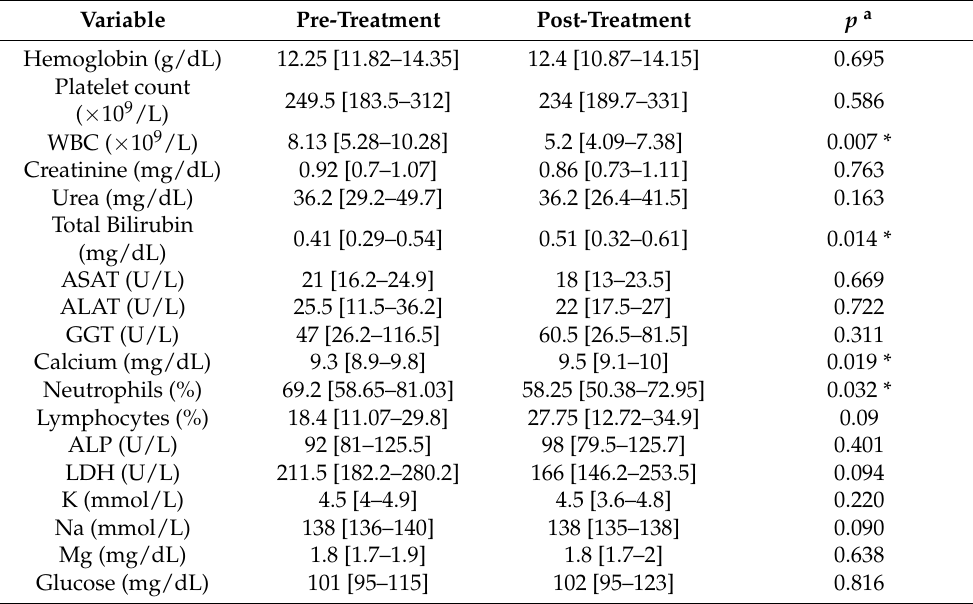
Table 1. General laboratory characteristics pre- and post-treatment.